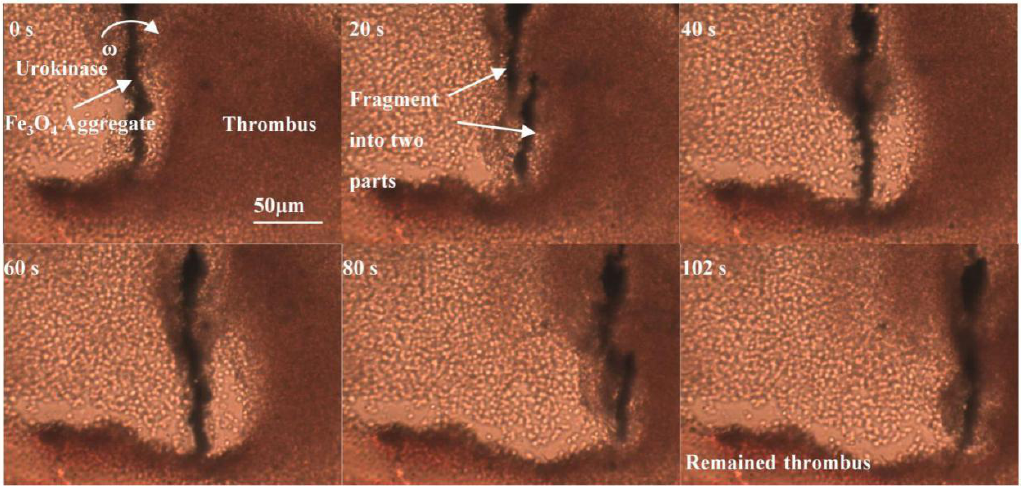
Figure 6. Image sequences of thrombus removal by the RMF-guided Fe 3 O 4 NPs.